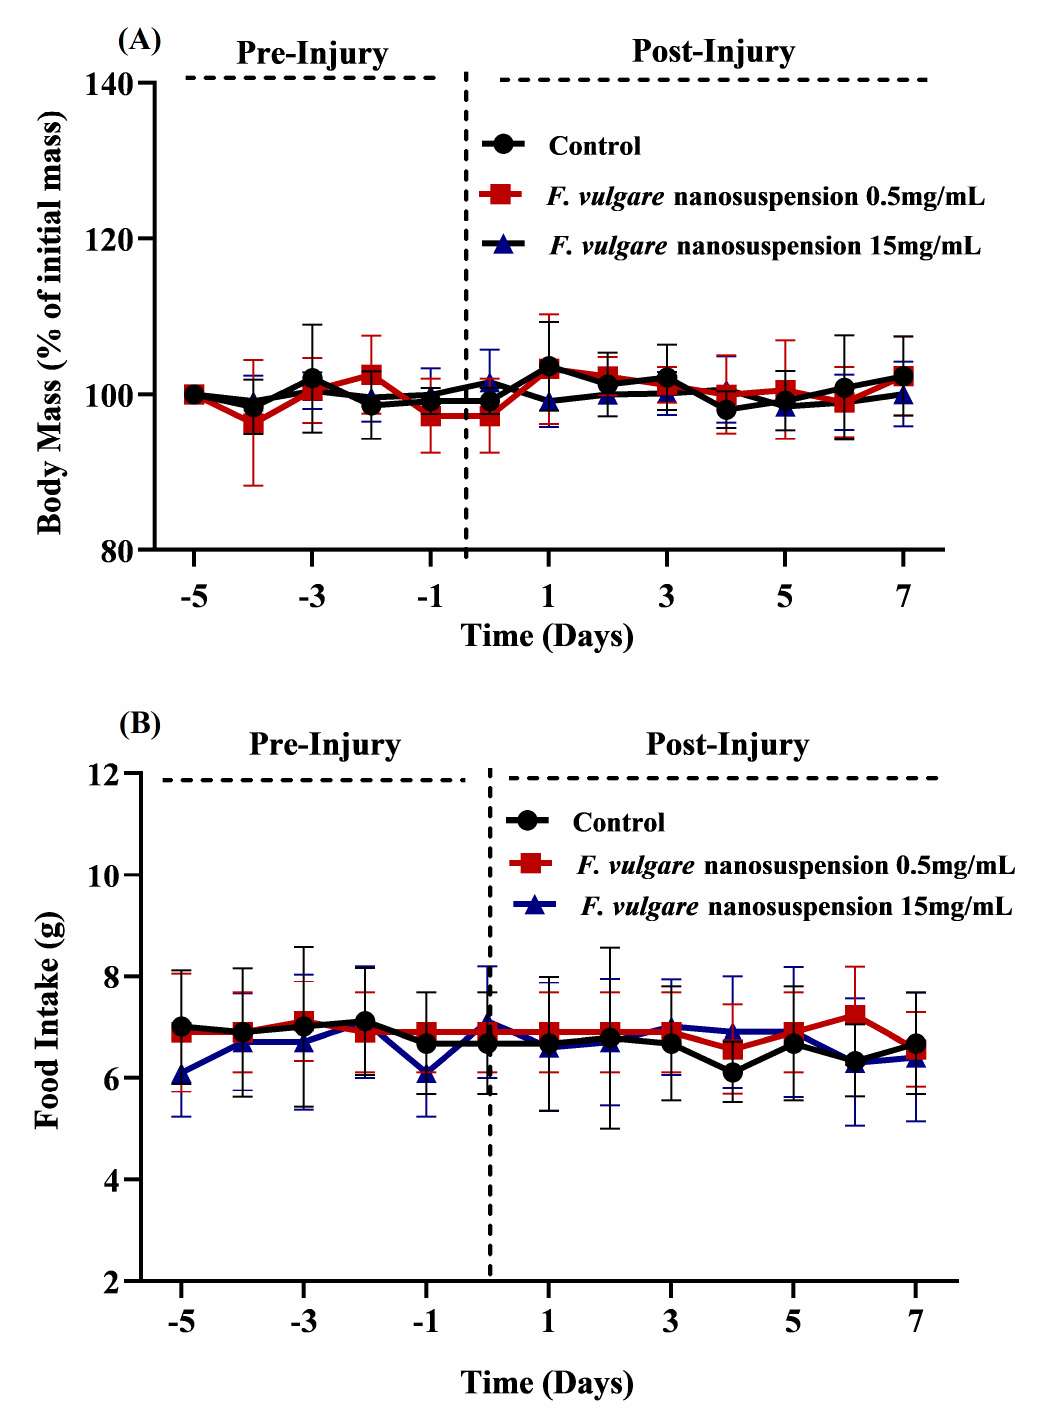
Figure 2. Impact of F. vulgare on the mice ( A ) body mass and ( B ) food intake.